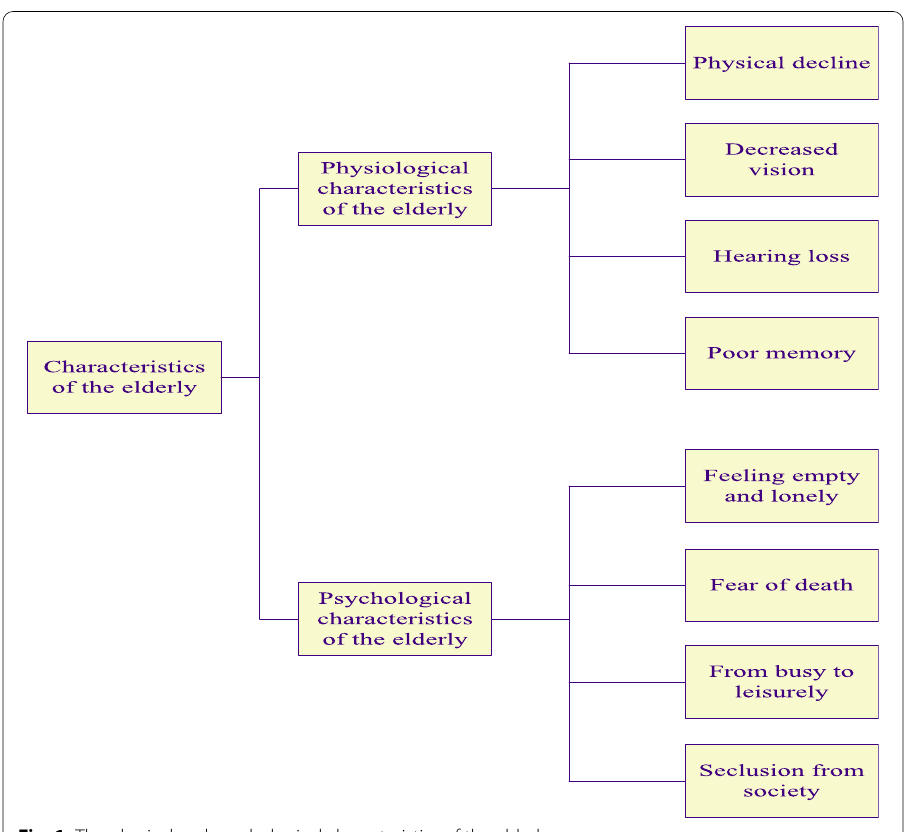
Fig. 1 The physical and psychological characteristics of the